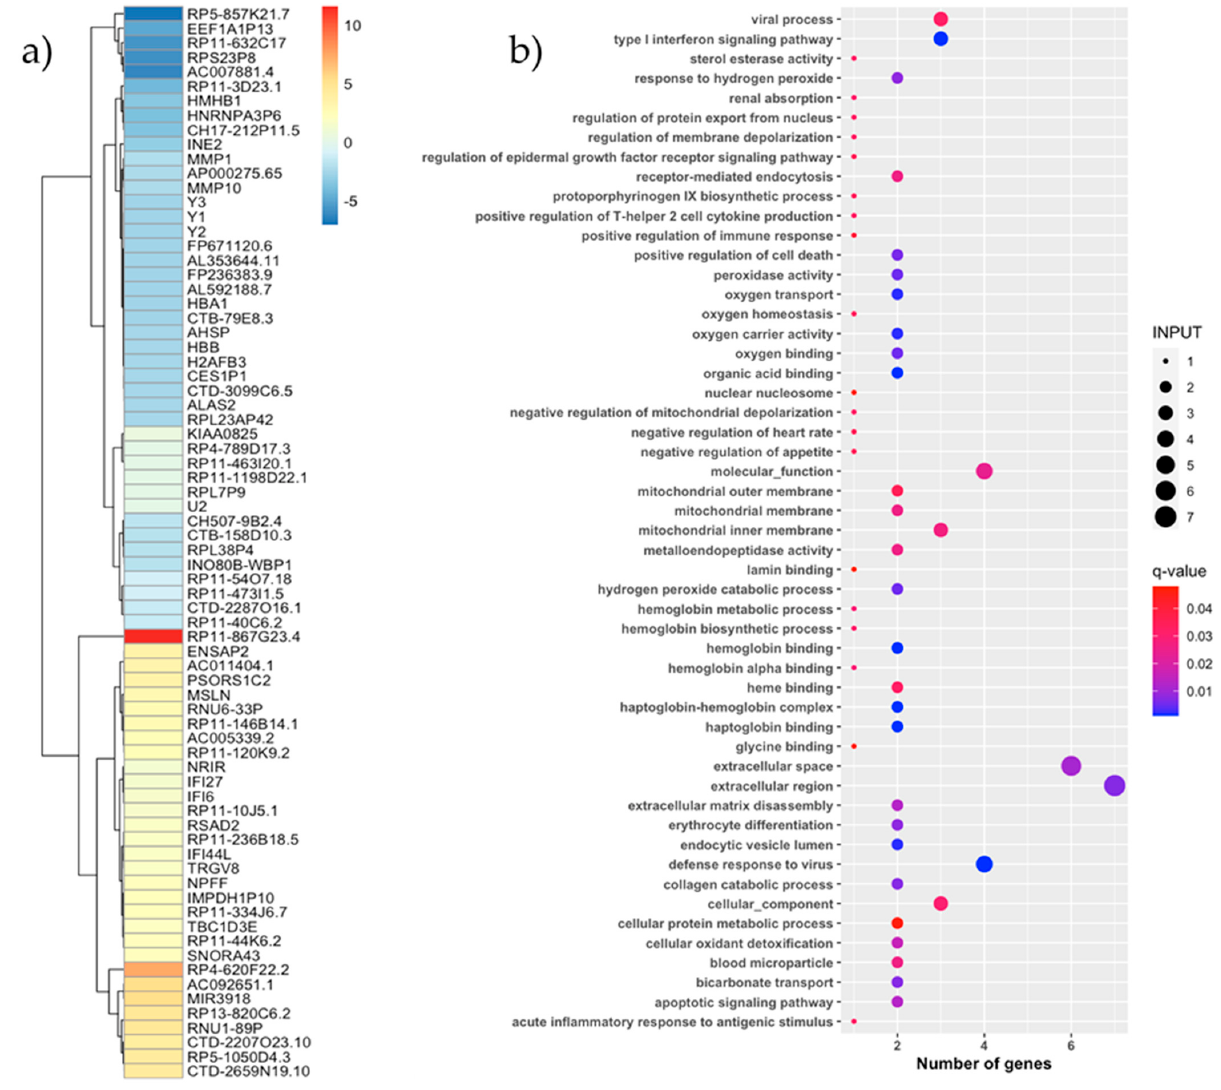
Figure 4. RNAseq transcriptomic analysis. ( a ) Heatmap of the fold change of the differential expressed genes between responder and non-responder individuals. The differential expressed gene symbol obtained from Ensembl genecode were showed in the vertical axis. The positive values (red scale colors) correspond to the upregulated genes in responder subjects, and the negative values (blue scale colors) correspond to the downregulated genes in responder subjects. The differential expressed genes were obtained using the ANOVA test, and a p -value < 0.05 was considered significant. ( b ) Enrichment analysis of the differential expressed genes in the responder group. The functional annotation was obtained using KOBAS software and the Gene Ontology (GO) database. The differential expressed pathways with q-value < 0.05 were considered significant. Patients were considered as responders with a delta VL set point >0.5 log10